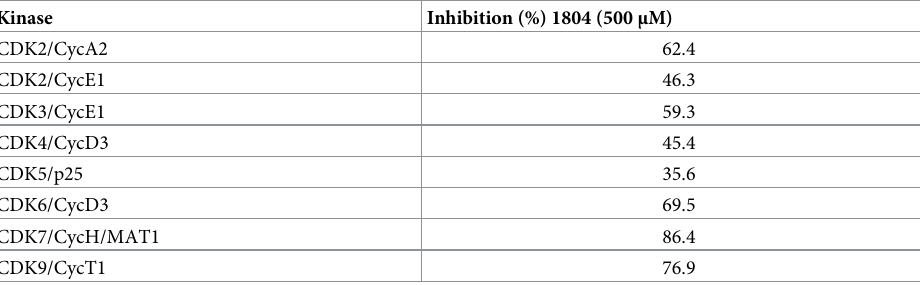
Table 4. Inhibitory effects of compound 1804 on various